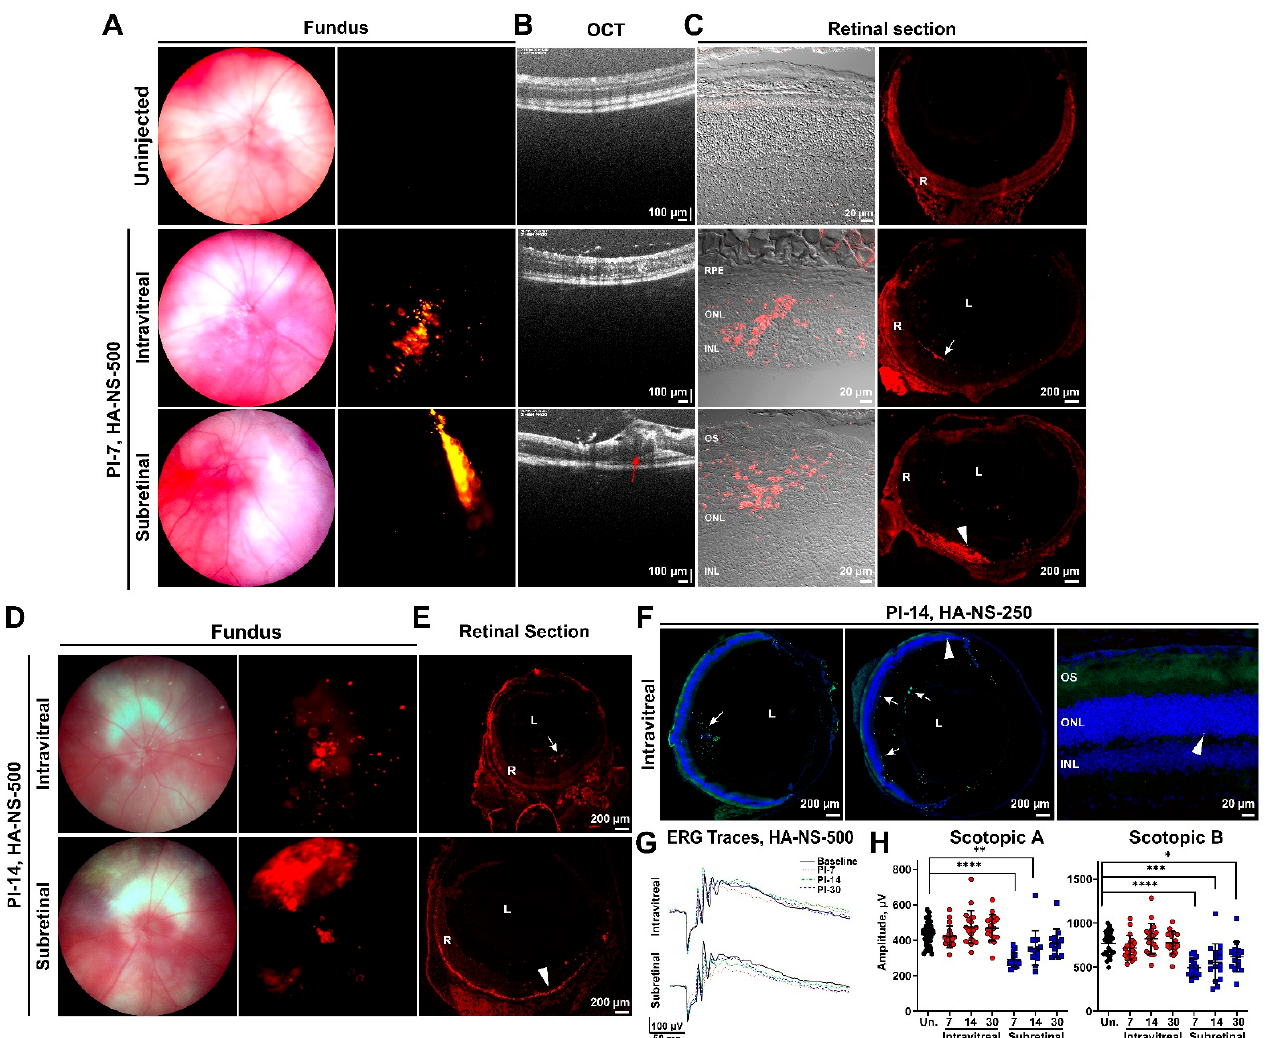
Figure 4. Intravitreal injection does not lead to wide distribution of HA-NS-500 or HA-NS-250 in the retina. ( A – E ) HA-NS-500 were injected either intravitreally or subretinally into the adult mouse retina. Follow up was performed at PI-7 days ( A – C ), or PI-14 days ( D , E ). ( A , D ) Shown are representative brightfield (left) and RFP (right) fundus images. ( B ) In vivo retinal cross sections were captured via OCT in the region of the injection. Red arrow highlights retinal disruption in subretinally injected eyes. ( C ) Tissues were harvested and cryosectioned. Left panel shows native rhodamine fluorescence (red) within localized areas of the retina. Middle panel shows native rhodamine fluorescence in whole retinal cross section, arrows highlight accumulation of HA-NS-500 along the ILM, arrowheads highlight accumulation in the subretinal space. ( D ) Shown are representative brightfield and RFP fundus images (as in ( A )) captured at PI 14 days. ( E ) Shown are representative retinal cross sections with native red signal (as in ( C )). Arrows show accumulation of HA-NS-500. ( F ) HA-NS-250 were injected and tissues harvested at PI-14 days. Shown are native fluorescein fluorescence (green) and DAPI (blue). Arrows highlight accumulation of HA-NS-250 in the vitreous, along the lens edge, and along the inner retinal edge. ( G , H ) Full-field scotopic ERGs ( G ) were recorded from uninjected eyes (black) and from HA-NS-500 injected eyes at various timepoints post-injection (red circles and blue squares). Line and error bars show mean ± SD. ( H ) For ERG, n = 10–12 injected eyes per group. * p < 0.05, ** p < 0.01, *** p < 0.001, and **** p < 0.0001 by one-way ANOVA with Tukey’s multiple comparison test. RPE: retinal pigment epithelium, ONL: outer nuclear layer, INL: inner nuclear layer, L: lens, and R: retina. Scale bars: 20 µ m ( C , F ), 100 µ m ( B ), and 200 µ m ( C , E , F